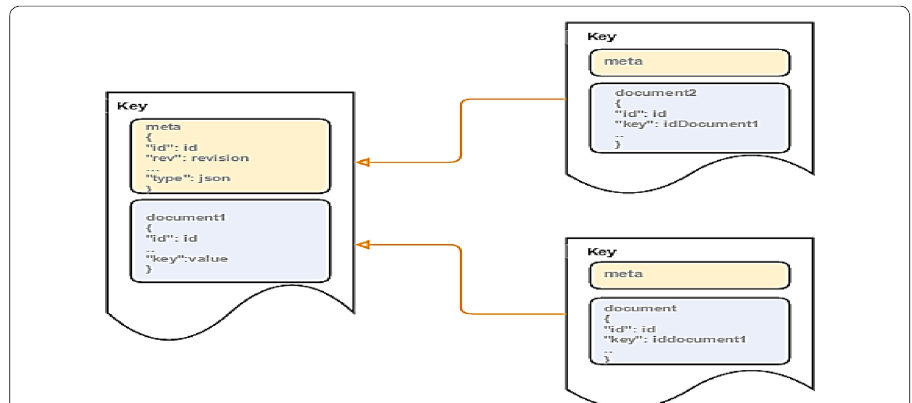
Fig. 5 Representation of stored